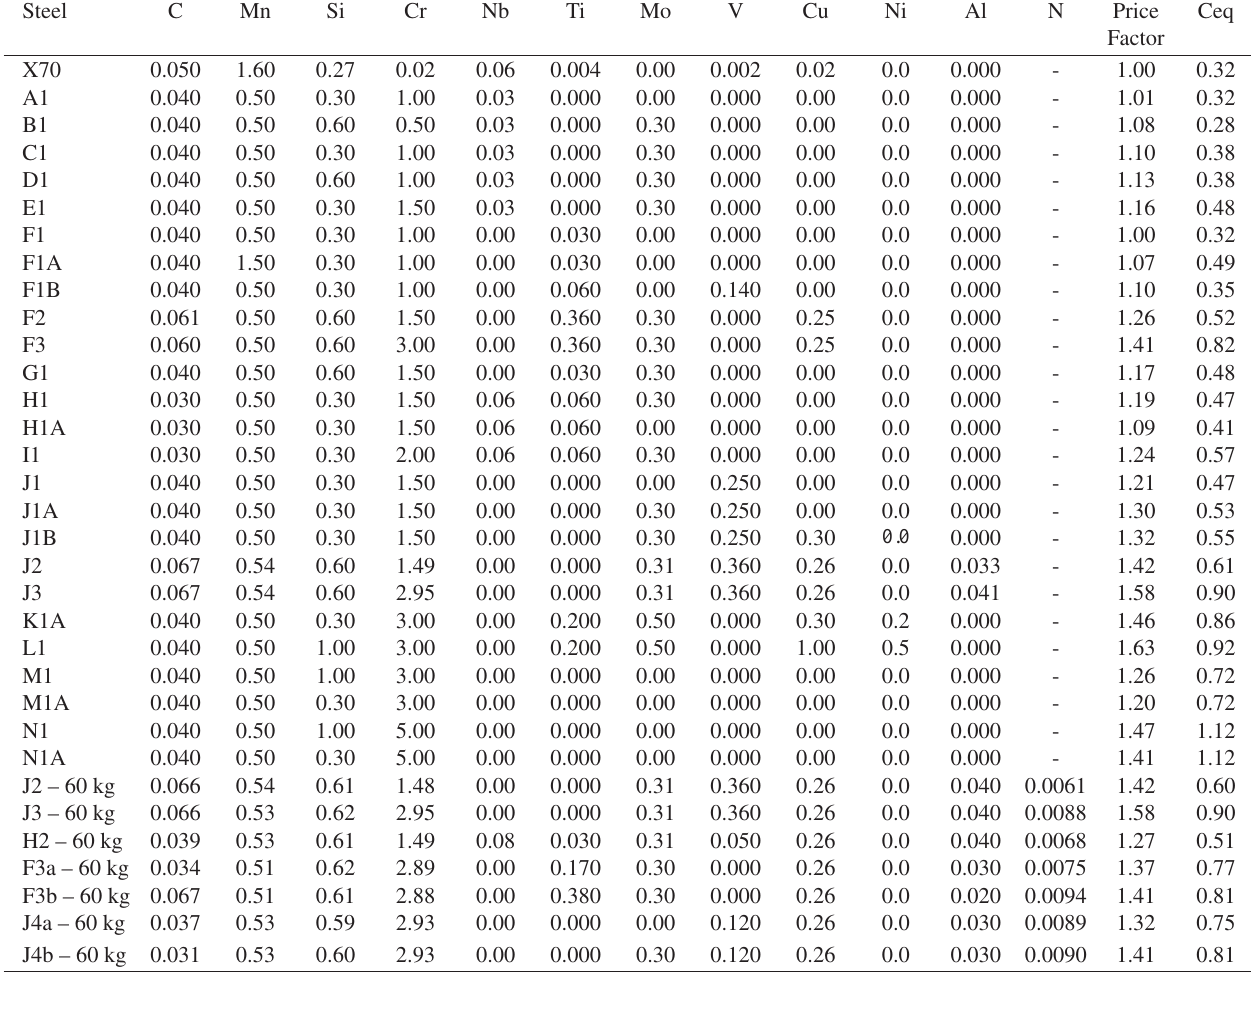
Table 1. Compositions of reference steel X70 and experimental steels (in wt. (%)) (Ceq is the carbon equivalent value). Steel